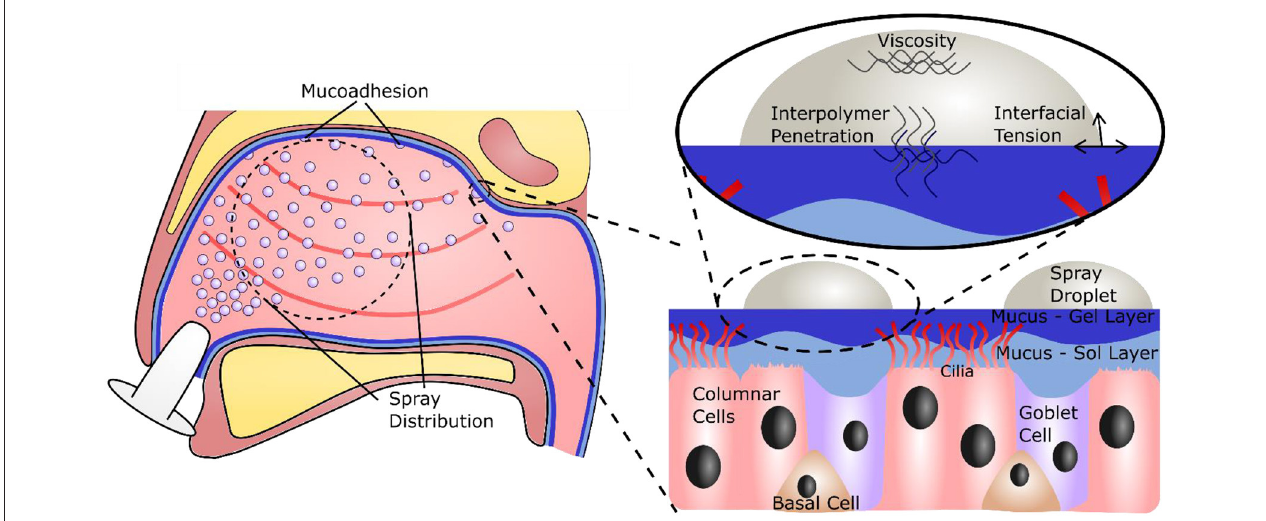
FIGURE 1 | Illustration of the nasal cavity, showing the necessity for a large, even spray distribution and subsequent adhesion to the nasal mucus. A focus on the nasal mucosa shows the specialized epithelial cells and the mucus bi-layer they produce. A further focus shows the important forces on and within a droplet that will govern retention time on the mucosa.